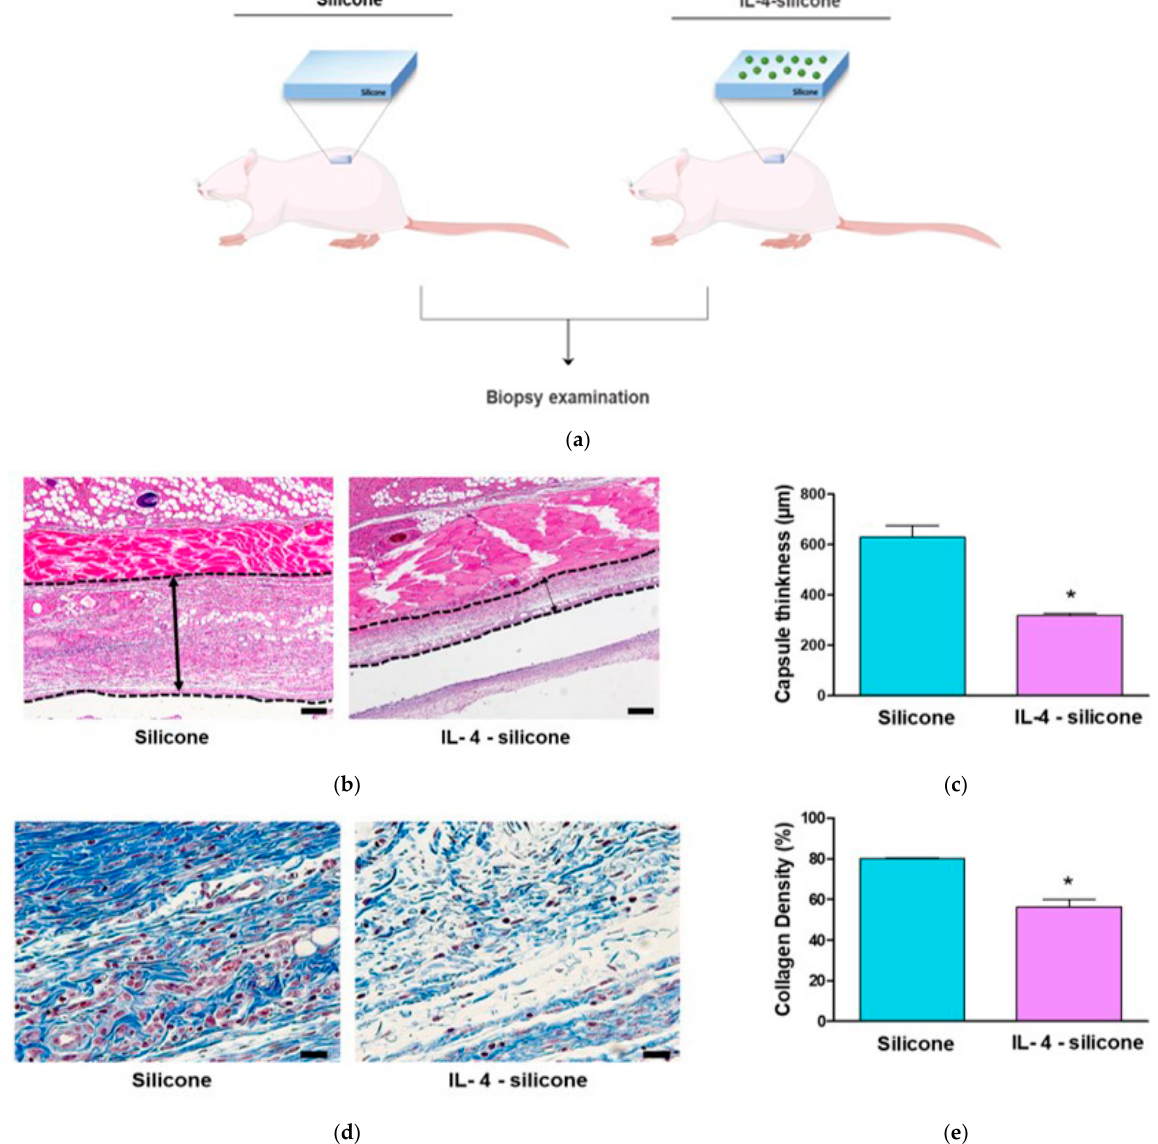
Figure 4. The effect of the IL-4-coated silicone implant on fibrous capsule formation in vivo. ( a ) A schematic diagram of the implantation of silicone implants with or without an IL-4 coating in SD rat. ( b ) Representative images of capsular formation around the silicone implants and ( c ) profiles of capsule thickness. The scale bars are 1 mm. The double-headed arrows indicate the capsule thickness. ( d ) Representative images of collagen formation around the silicone implants and ( e ) profiles of collagen density. The scale bars are 1 mm. The data are means ± SEMs, five animals per group. * Significantly different ( p < 0.05; t -test) from the bare silicone implant group.